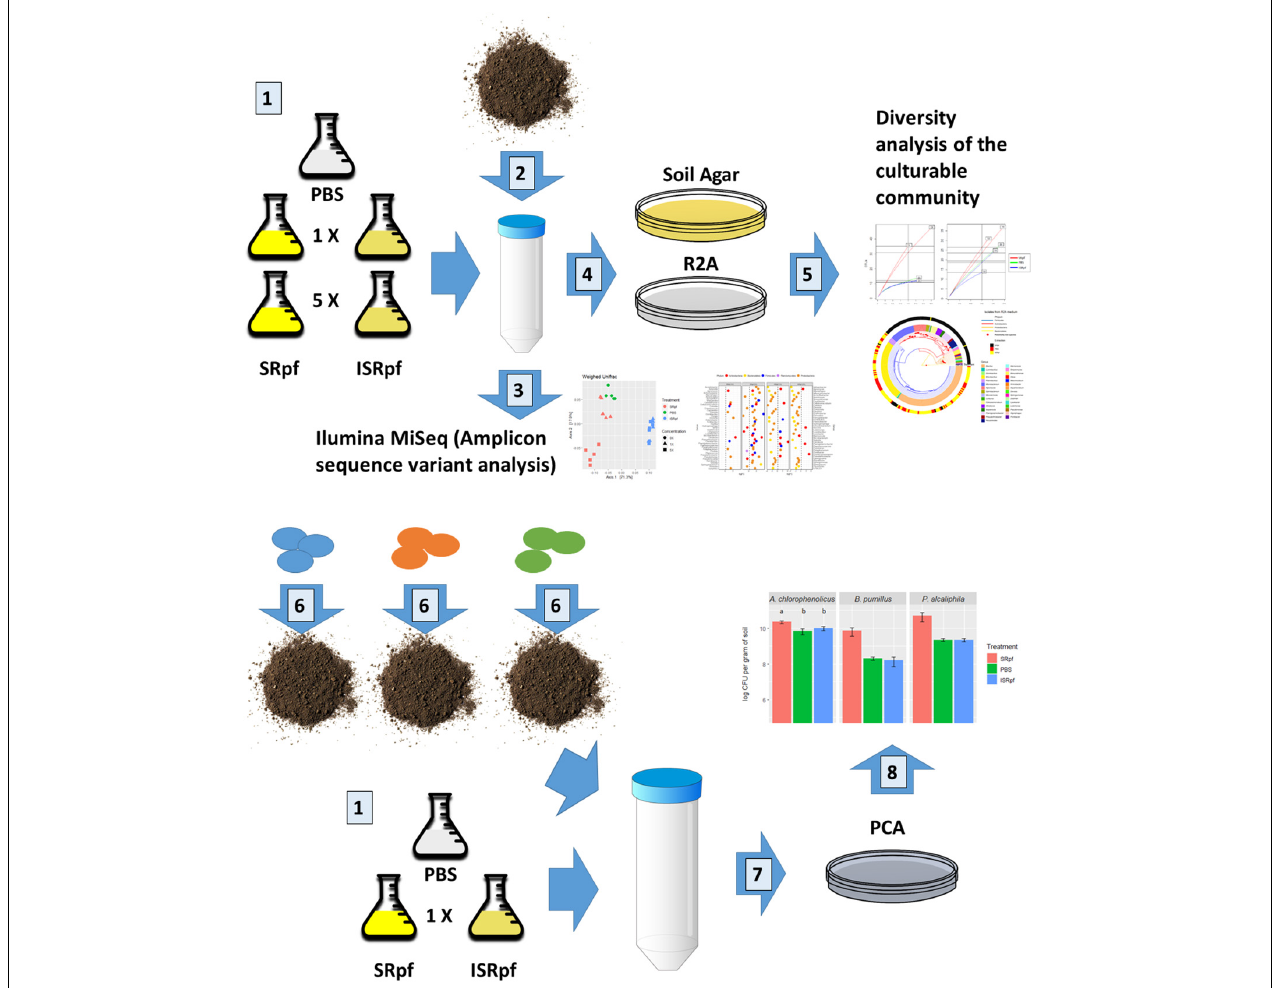
FIGURE 1 | Summary of the experimental design. Number 1: M. luteus was cultured in lactate minimal medium. A concentration 5 × was obtained by culturing a 5 × larger volume and concentrating it to the volume of 1 × . Both concentrations were divided in two and one half was inactivated. Supernatant components of the M. luteus culture larger than 3 kDa were then washed with PBS. A PBS only extraction was used as control. Number 2: 1 g of soil was mixed with 9 ml of either of the 5 extraction media. Soil suspensions were incubated for 1 day at 28 ◦ C. Number 3: DNA from the soil suspensions was extracted and 16S rRNA sequences amplified (amplicon sequence variants analysis). Number 4: soil suspensions of each extraction strategy (number 1) were serially diluted and plated on two different solid media. Number 5: colonies were selected from the plates and dereplicated with MALDI TOF-MS and their 16S rRNA genes were partially sequenced. For the bioaugmentation experiment (number 6), three different bacteria were inoculated in the sterile soil and incubated for a month and extracted as described in number 1 (just 1 × concentration). Number 7: the soil suspensions with the inoculated bacteria were serially diluted and plated on PCA (drop method). Number 8: colonies were counted for each